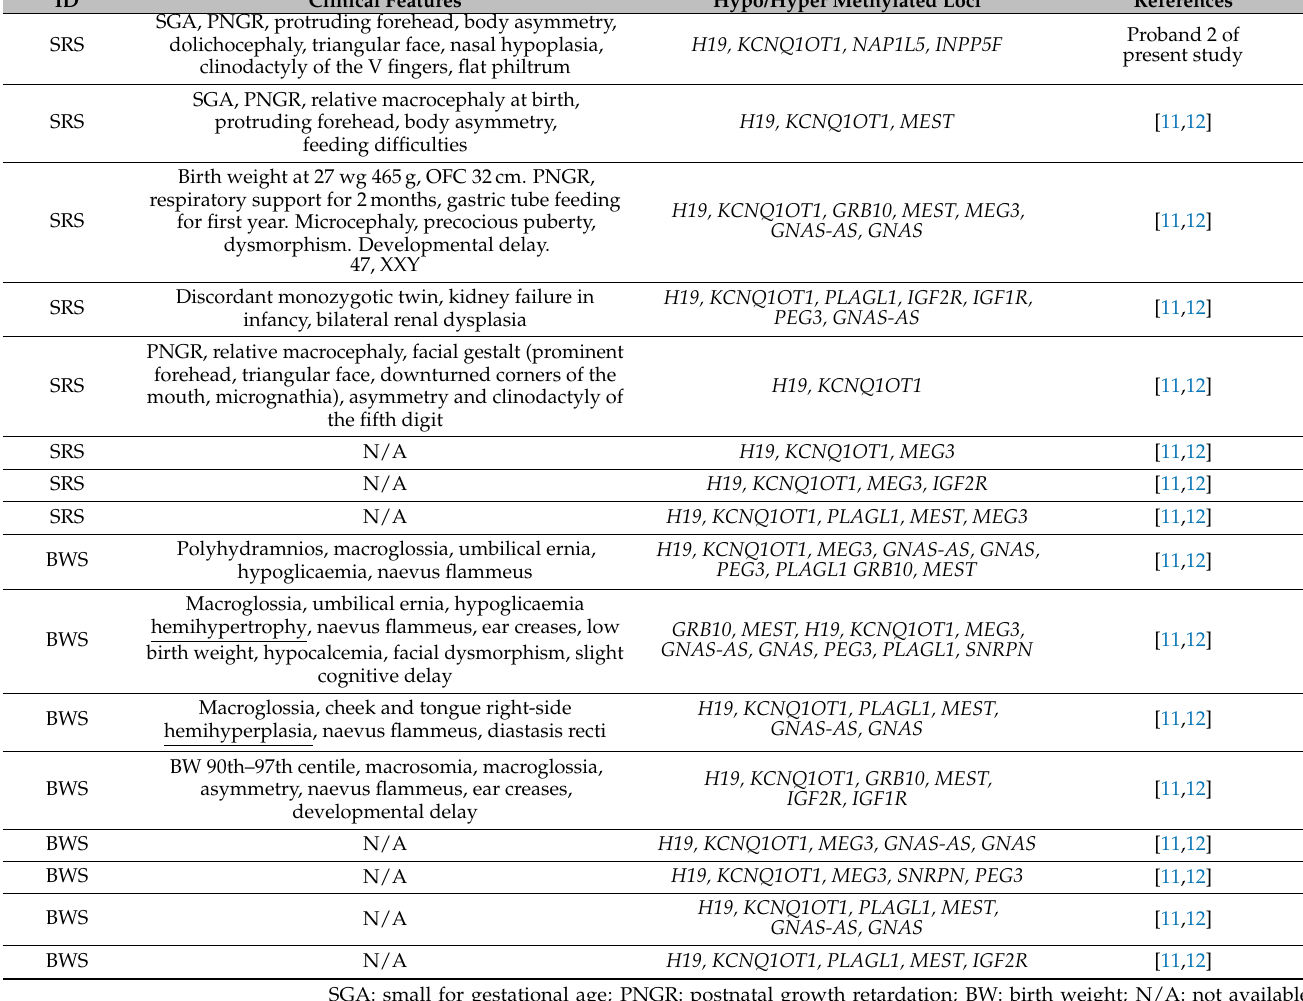
Table 1. Epigenotype and clinical features of patients with the LOM in both IC1 and IC2 reported in